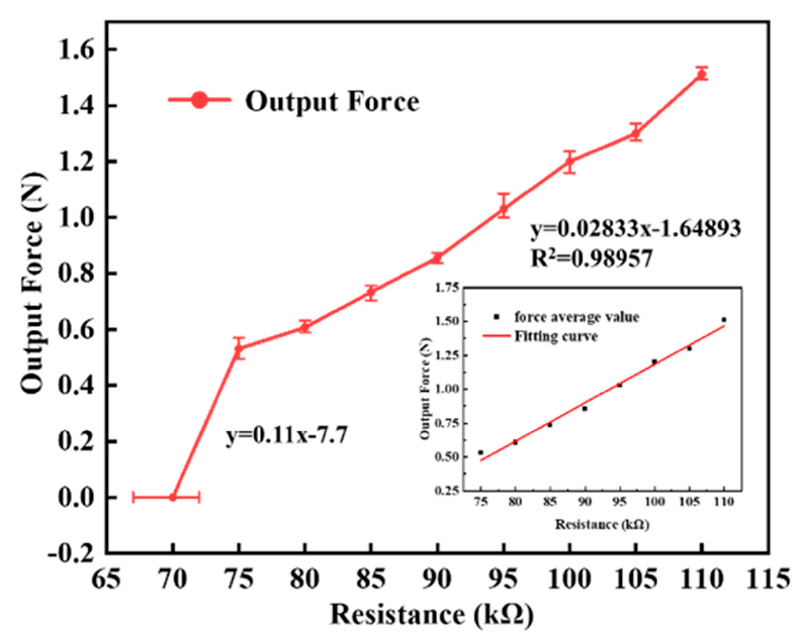
Figure 13. Relationship between lower electrode resistance versus output force of SEHPA under the closed-loop control system.